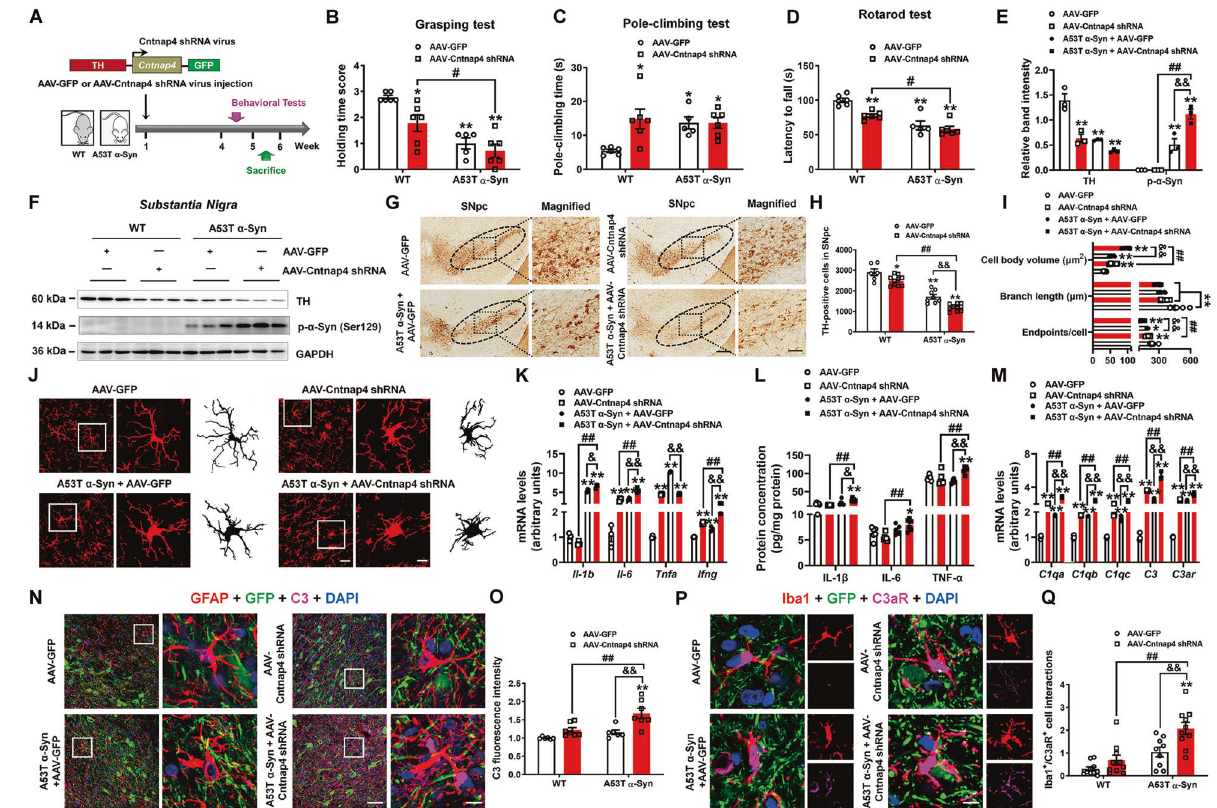
to examine bradykinesia in the mice. D The rotarod test was used to examine the motor coordination of mice; n = 6, 6, 5, and 6 in the WT + AAV-GFP, WT + AAV-Cntnap4 shRNA, A53T α -Syn + AAV-GFP, and A53T α -Syn + AAV-Cntnap4 shRNA groups, respectively. E , F The protein expression levels of TH and phosphorylation of α -synuclein at serine 129 in the SN were determined by western blotting; n = 3 per group. G , H Immunohistochemical staining and quanti fi cation of TH-positive cells in the SNpc. Scale bars: 100 μ m. Magni fi ed images are shown in the right column. Scale bars: 50 μ m; n = 6 – 10. I , J Immuno fl uorescence staining and quanti fi cation of Iba1-positive cells in the SNpc. Scale bars: 30 μ m. Magni fi ed images are shown in the middle column, and skeletal diagrams of Iba1-positive cells are shown in the right